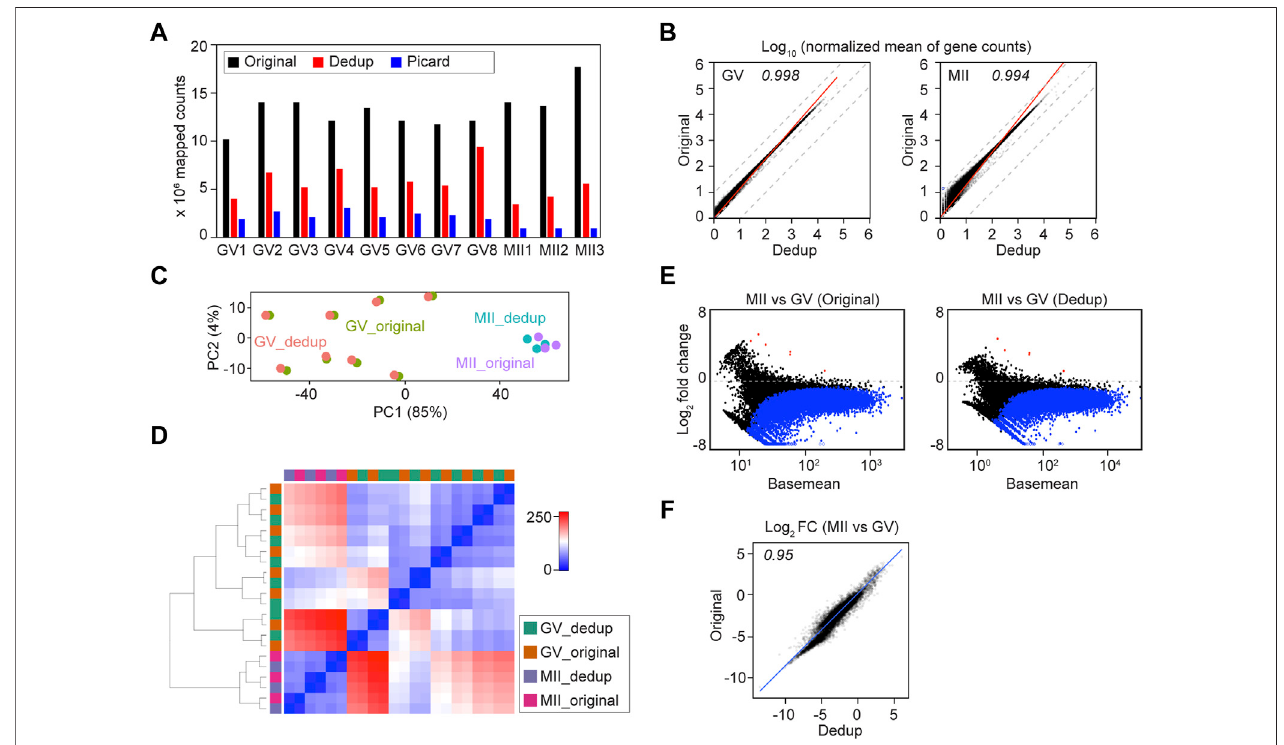
FIGURE4| Deduplication of soRNA-seq reads does not signi fi cantly alter downstream analyses. (A) Bar graph of Original, UMI-deduplicated (Dedup) and Picard-deduplicated counts. GV1-GV8, MII1-MII2 are oocyte IDs from GSE141190 RiboMinus datasets. (B) Plots of transcript abundance regression analysis of Original vs. Dedup gene counts. The x-axis and y-axis are log 10 normalized mean counts from Original and Dedup. (C,D) Principal component analysis (C) and sample distance matrix (D) of combined Original and Dedup. (E) Differential analysis of MII vs. GV in Original and Dedup. (F) Comparison of the log 2 fold change (MII vs. GV) in Original and Dedup. The x-axis and y-axis are log 2 fold change (MII vs. GV) values in Original and Dedup.